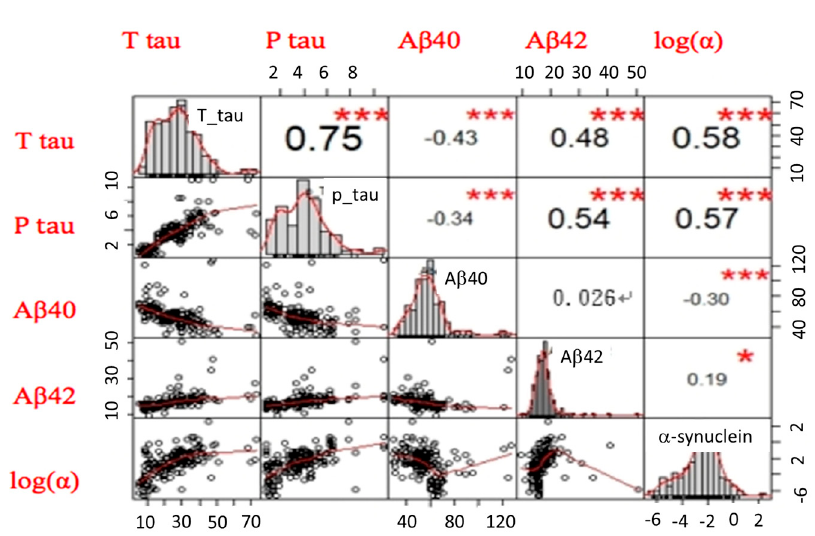
Figure 4. The correlation matrix between each biomarker from three groups, including normal controls, patients with mild cognitive impairment (MCI), and AD. The upper triangular part of the matrix is the correlation coefficients between any two biomarkers. The lower triangular part of the matrix is the scattered-plot graphs of any two biomarkers. The main diagonal part of the matrix is the distribution graphs of each biomarker. log( α ) is the log of α -synuclein. * p < 0.05; *** p < 0.001.